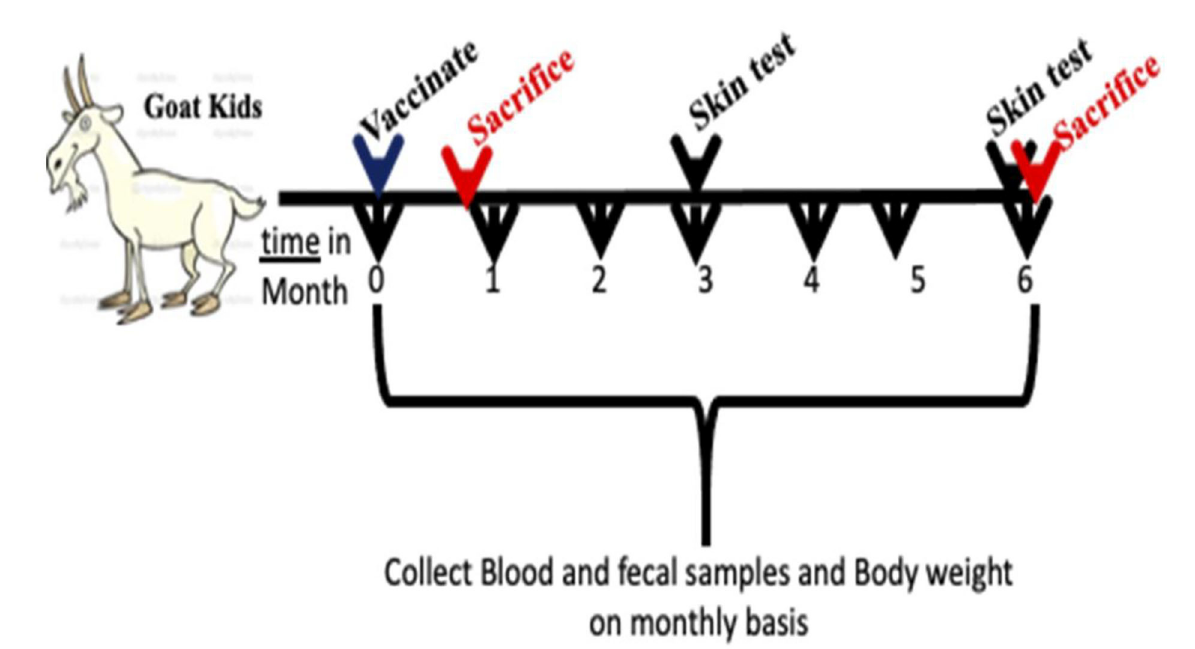
FIGURE1 Sketch for experimental design used in this study. Goat kids at 28 days of age were vaccinated by subcutaneous injection or intranasal and monitored for 6 months post vaccination. Two sacrifices were conducted at 3 weeks then at 6 months post vaccination. Feces, blood and saliva were collected once a month throughout the experiment